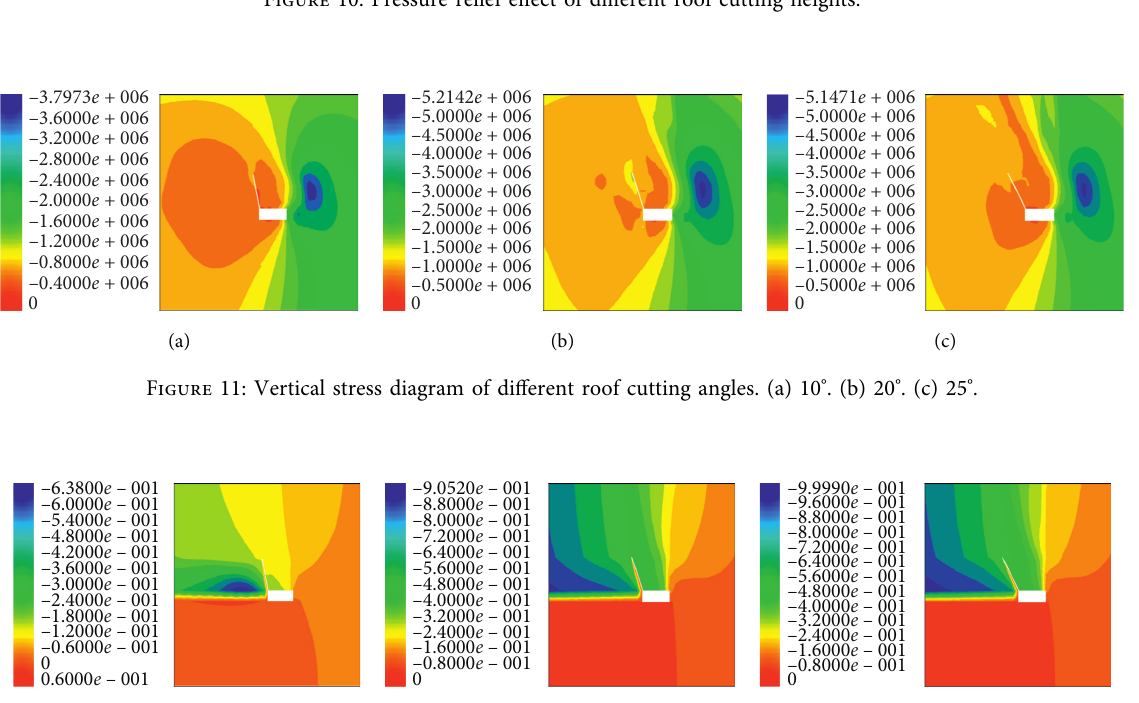
Figure 10: Pressure relief effect of different roof cutting heights.